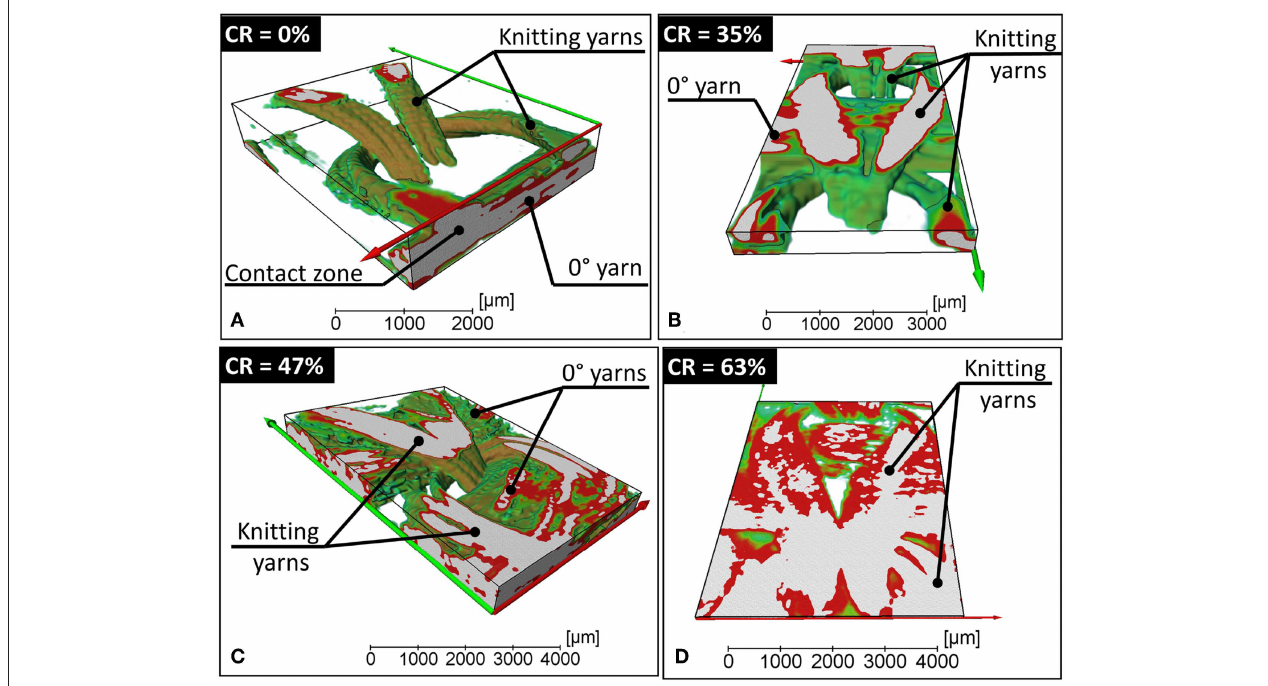
FIGURE 12 | Impregnation degree of knitting yarns. (A–D) Correspond respectively to the compaction ratios of 0; 35; 47 and 63%.